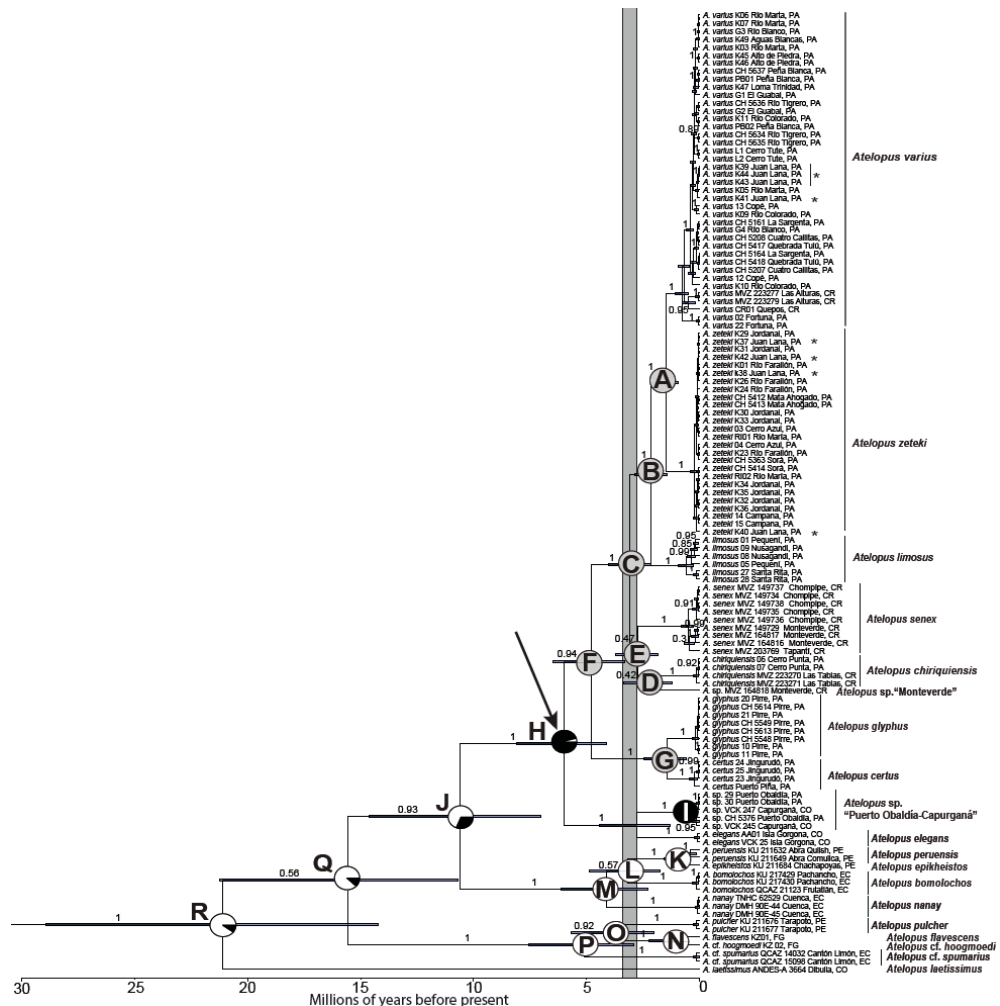
Figure 3. A timetree of Atelopus diversification from a relaxed-clock MCMC Bayesian analysis using the software BEAST 2, calibrated using a mitochondrial DNA substitution rates of mitochondrial genes of bufonid frogs of Macey et al. [53], as corrected by Crawford [54]. Outgroup samples of non- Atelopus bufonid genera were trimmed for improved visualization of the ingroup and are shown in Supplementary Figure S3. Numbers above branches are the posterior probabilities of adjacent nodes. 95% credibility interval of the age of each node is indicated by horizontal bars. The grey vertical shading shows an interval between 3.2 to 2.76 million years ago (Ma) indicating the estimated time when gene flow among shallow marine animals and movement of surface water across the Panamanian Isthmus ended, according to O’Dea et al. [36]. Note that the minimum age of node H, the oldest node reconstructed as being entirely Central American, is still older than 3.2 Ma. Shading in the circles on each node correspond to the ancestral area reconstructions under the DEC model (white refers to South America, pale grey to Central America, and black to ancestors recovered as inhabiting both continents), and the letters in each circle correspond to rows in Table 3. Specimens are indicated by their field or museum voucher number, or if not available, with an arbitrary number and the name of the locality where they were obtained (sample details in Supplementary Table S1). Specimens from the locality in which A. varius and A. zeteki are found in sympatry (Juan Lana, Panamá) are marked with asterisks.